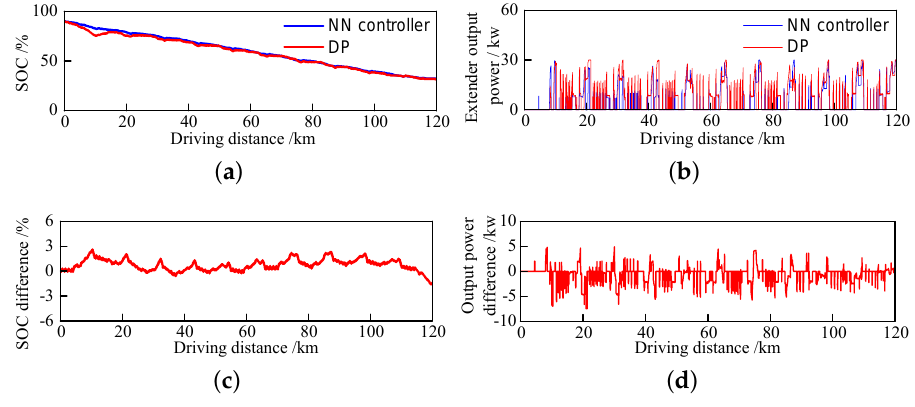
(d)Extender output power difference Fig. 7. Comparison between DP and NN controller results under the 120 km NEDC cycle Figure 8. Comparison between DP and NN controller results under the 120-km NEDC cycle. ( a ) Battery SOC variation; ( b ) extender output power comparison; ( c ) battery SOC difference; ( d ) extender output power